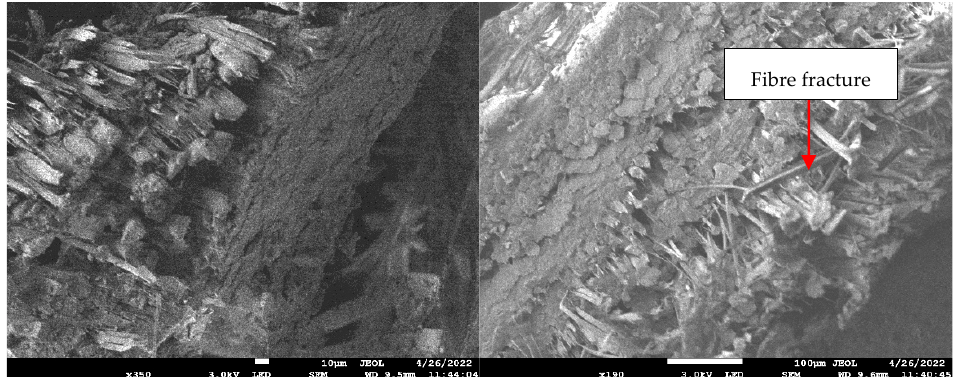
Figure 11. Scanning electron microscopy images of the PALF/Kevlar hybrid composite laminates under tensile loading.